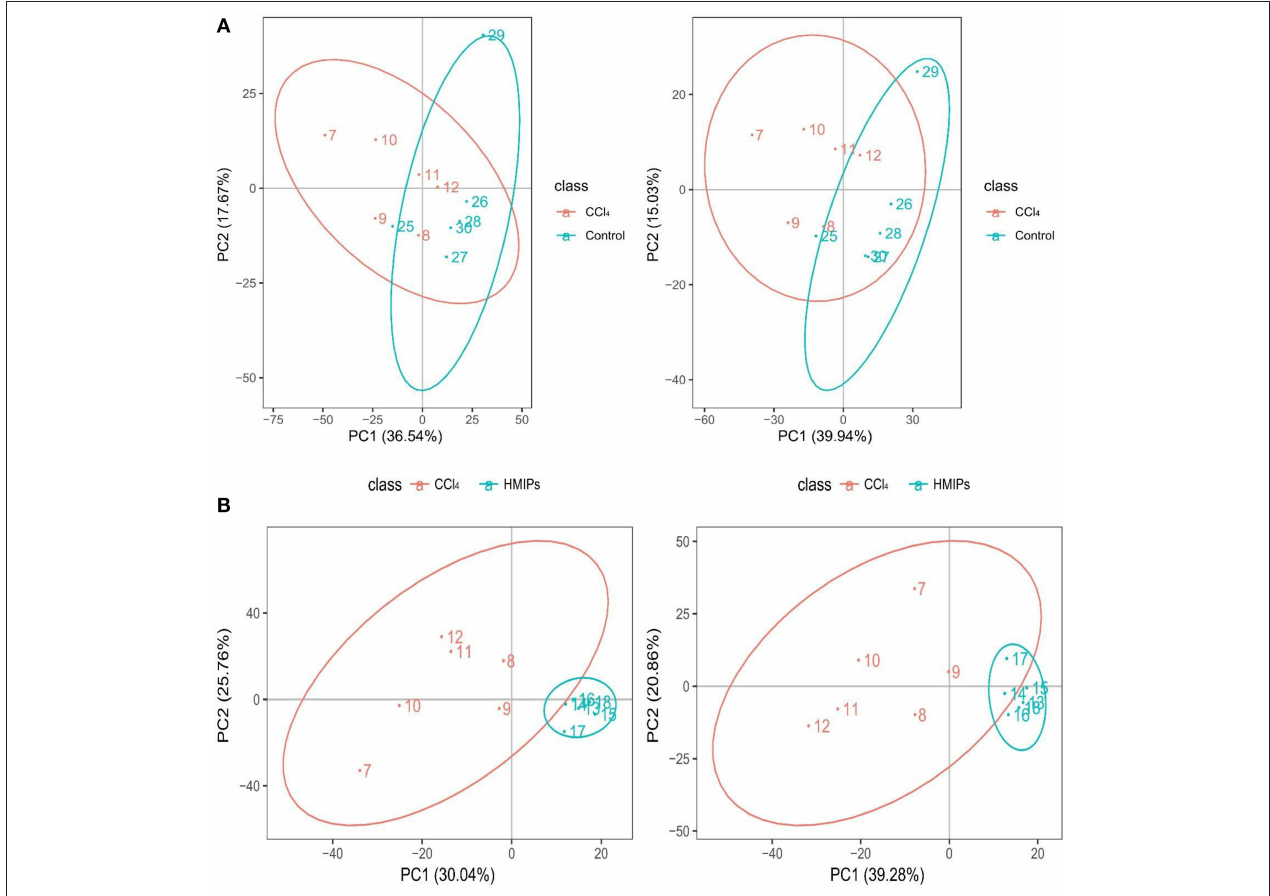
FIGURE 7 | Principal component analysis (PCA) score plots of the serum samples. (A) PCA score plots of the control and CCl 4 groups under the positive and negative ion models. (B) PCA score plots of the HMIP and CCl 4 groups under the positive and negative ion models.